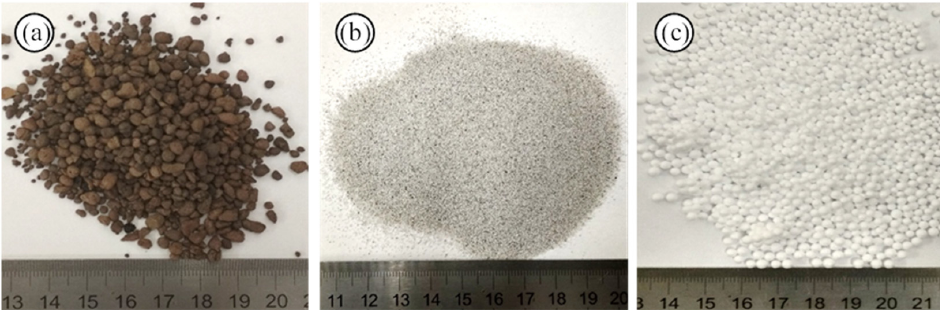
Figure 1. Raw materials used as fillers: ( a ) Liapor, ( b ) glass microspheres, and ( c ) EPS polystyrene. Silica fume is a by-product of the production of elemental silicon or alloys containing silicon in electric arc furnaces [16]. Silica fume significantly improves the overall compressive strength and bond strength of the geopolymer composites [4,17,18]. Basalt fiber help improve the mechanical properties and fire resistance of the building materials [19,20]. These two materials were used to improve the overall properties of all samples studied. 2.2. Sample Preparation The raw materials were mixed with weight ratios as reported in Table 1. The parametric study on the filler proportion was also performed out to better understand its influence on the performance of the sample. First, metakaolin powder (Mefisto L05) was mechanically stirred in the KOH-aqueous alkaline solution for four minutes at high speeds by means of the Eibenstock Automix 1801. The ground basalt fibers, and micro- silica (silica fume) were then added to the geopolymer mortar, and the mixing process was continued until the blend was homogenized. Finally, either one of these fillers (microspheres, Liapor, and polystyrene) were added to the geopolymer mortar to create the different geopolymers (GPs). The final geomortar was cast into the molds and tightly covered with plastic wrappers. The samples were cured for 28 days at room temperature. Table 1. Mixing proportions of the geopolymer samples. BGF Sample